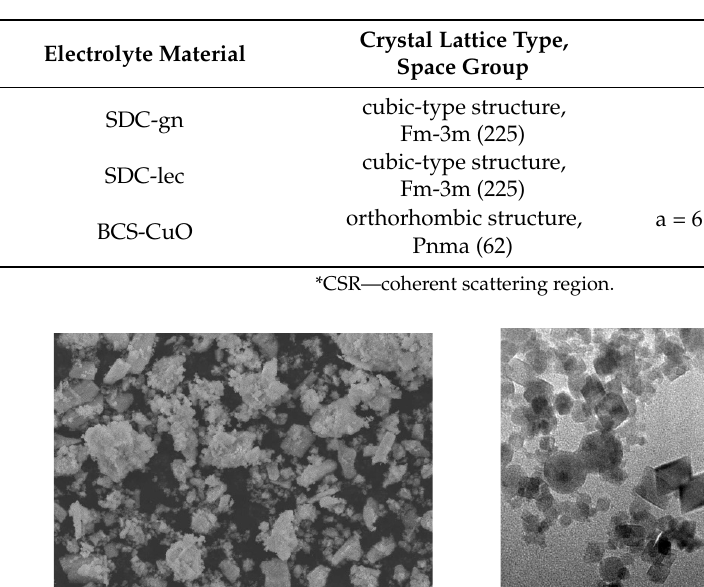
Table 1. Characteristics of the SDC-gn, SDC-lec and BCS-CuO electrolyte materials.